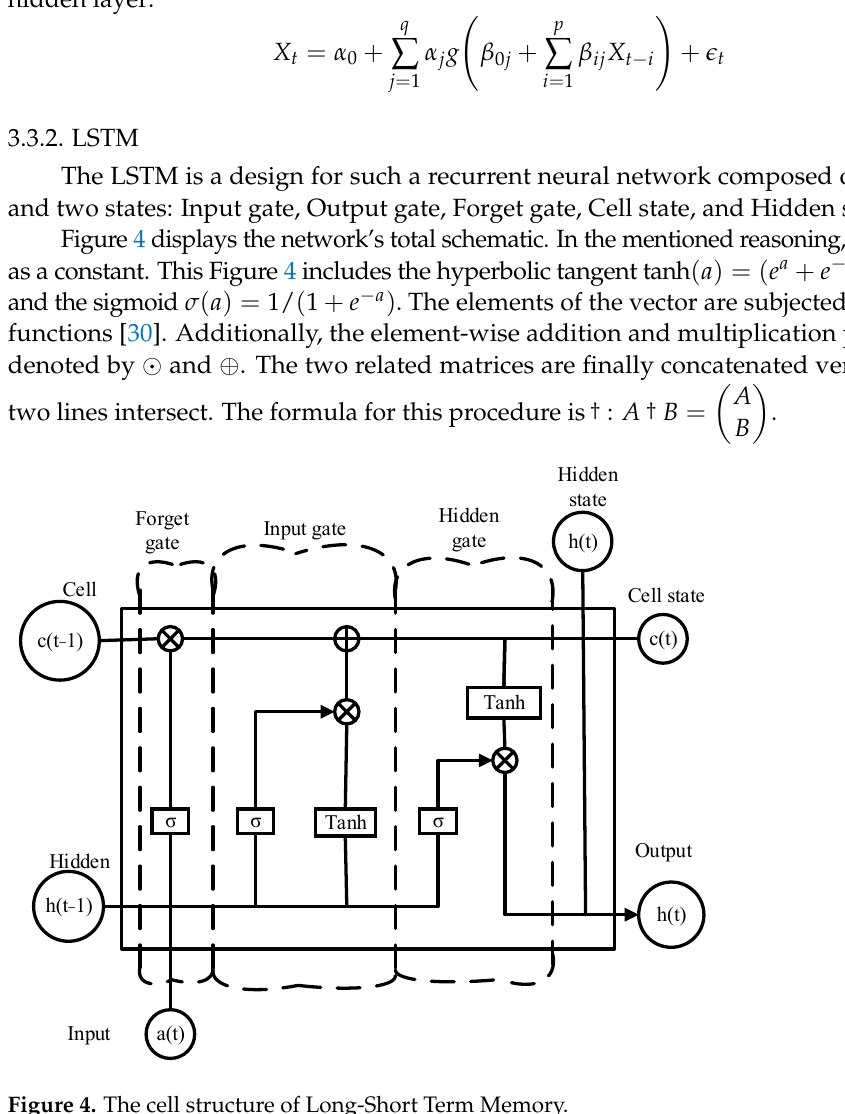
Figure 3. Multi-layer perceptron network graph layer.